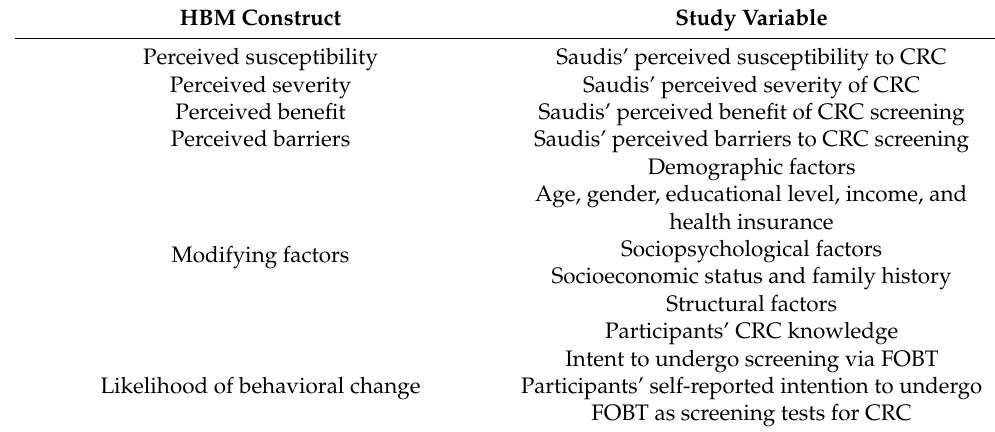
Table 1. Relationship of Health Belief Model components with current study